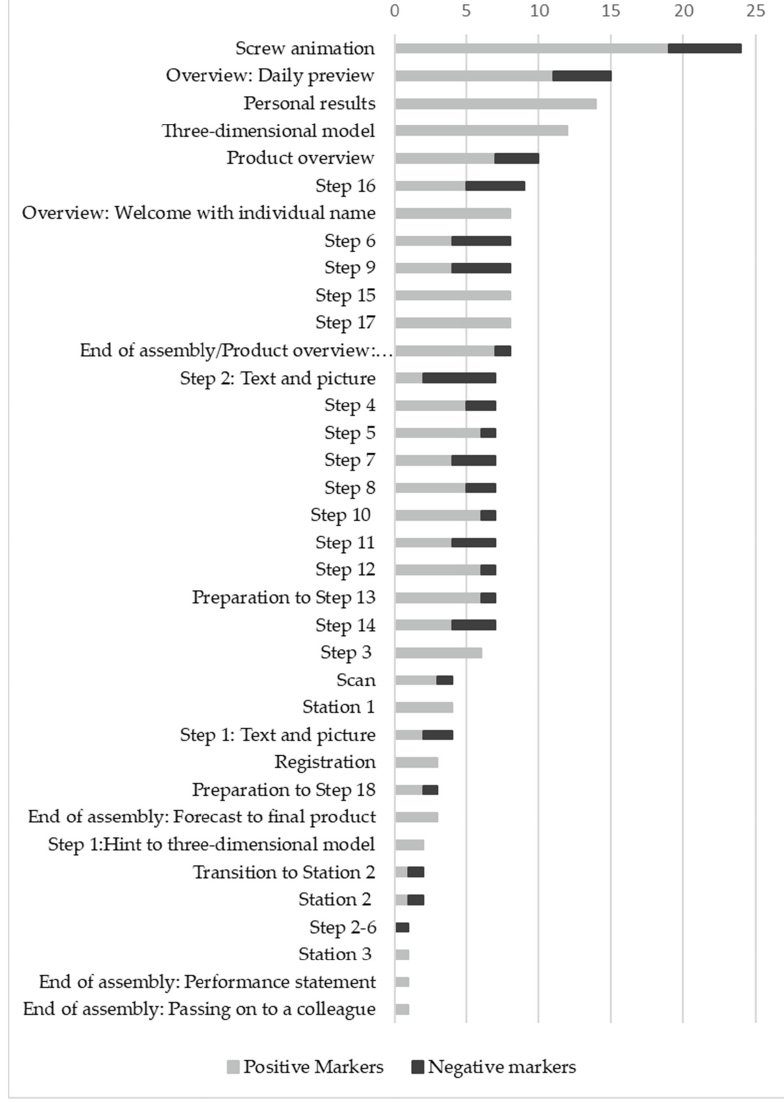
Figure 3. All set valence markers (positive and negative) assigned to respective design elements.